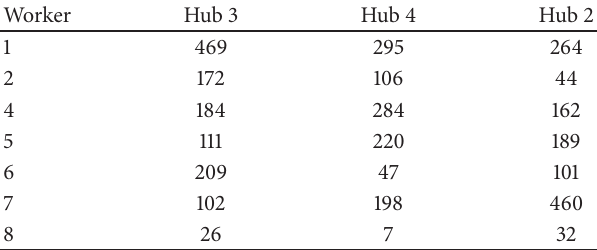
Table 7: The difference of total training cost for worker 𝑖 .